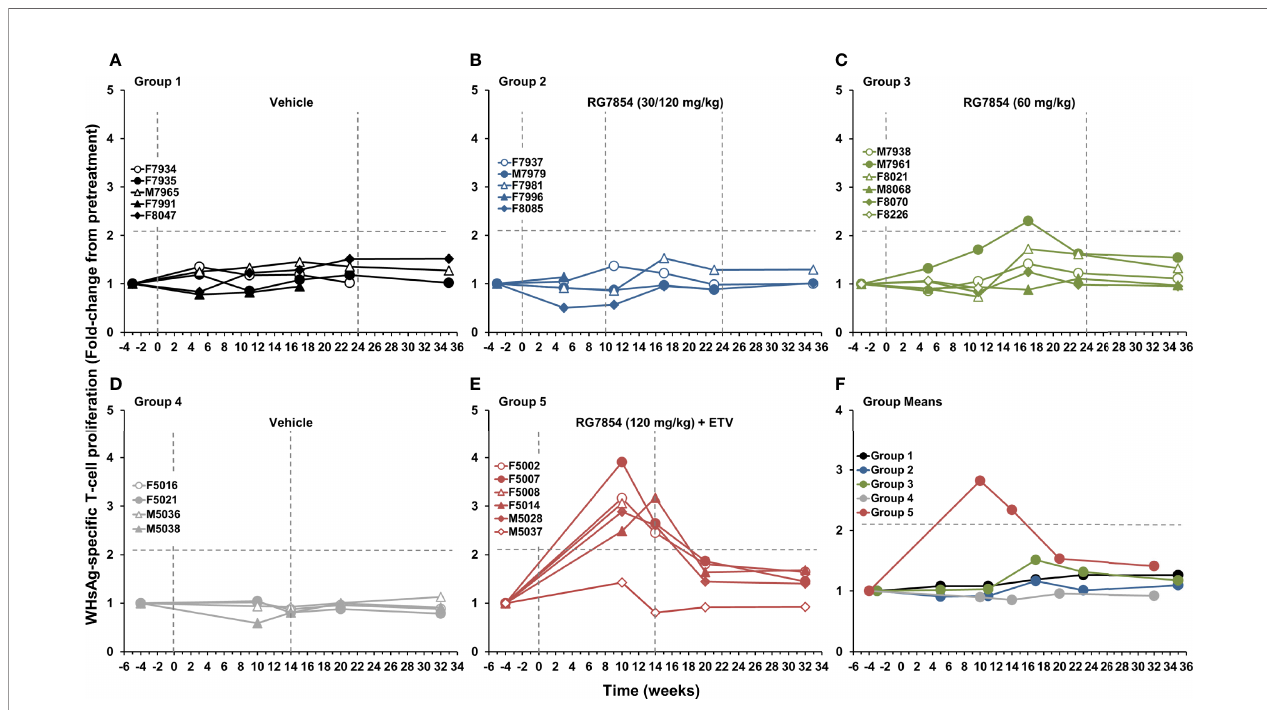
FIGURE 8 | Effect of RG7854, alone and together with ETV, on peripheral WHsAg-speci fi c T-cell response. Kinetics of PBMC proliferation to stimulation with WHsAg-derived peptides of individual woodchucks administered (A) placebo or RG7854 at doses of (B) 30/120 mg/kg or (C) 60 mg/kg in the monotreatment study and (D) placebo or (E) RG7854 at a dose of 120 mg/kg plus ETV in the combination treatment study. (F) Group mean WHsAg-speci fi c T-cell responses. The horizontal dotted lines indicate the cutoff for positive PBMC proliferation (i.e., ≥ 2.1-fold-change from the pretreatment baseline). The mean WHsAg-speci fi c T-cell response in Groups 2 and 3 was not signi fi cantly different to Group 1 ( P > 0.05) (Student ’ s t -test). The mean WHsAg-speci fi c T-cell response in Group 5 was signi fi cantly increased compared to Group 4 at weeks 10 and 14 ( P <